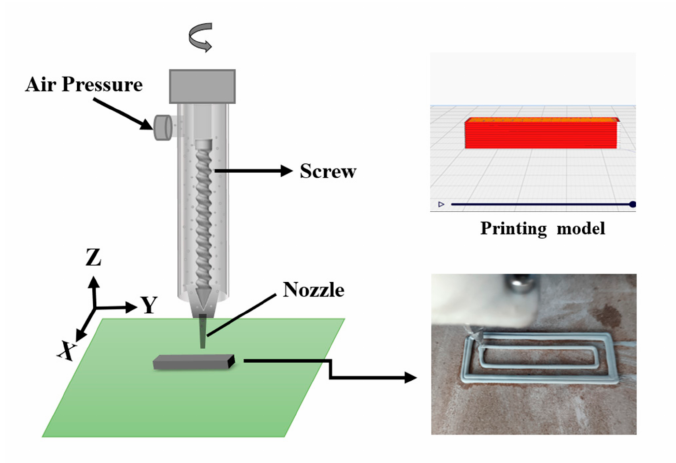
Figure 1. Schematic diagram of the 3D printing process for ceramic parts.